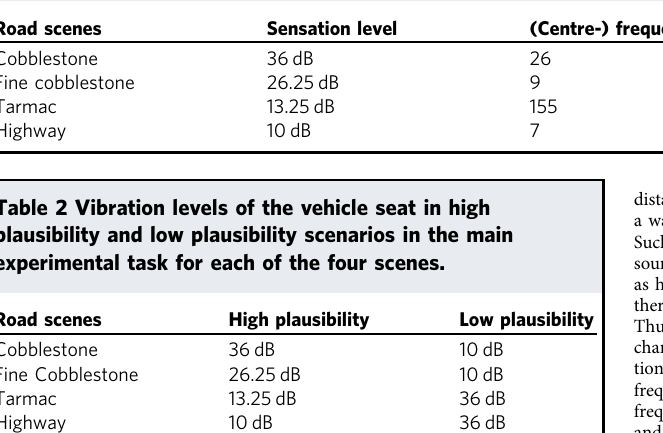
Table 1 Parameters of the synthesized vibrations at different sensation levels (parameters which are unde fi ned for the respective signal type are marked by “ NA ” ).